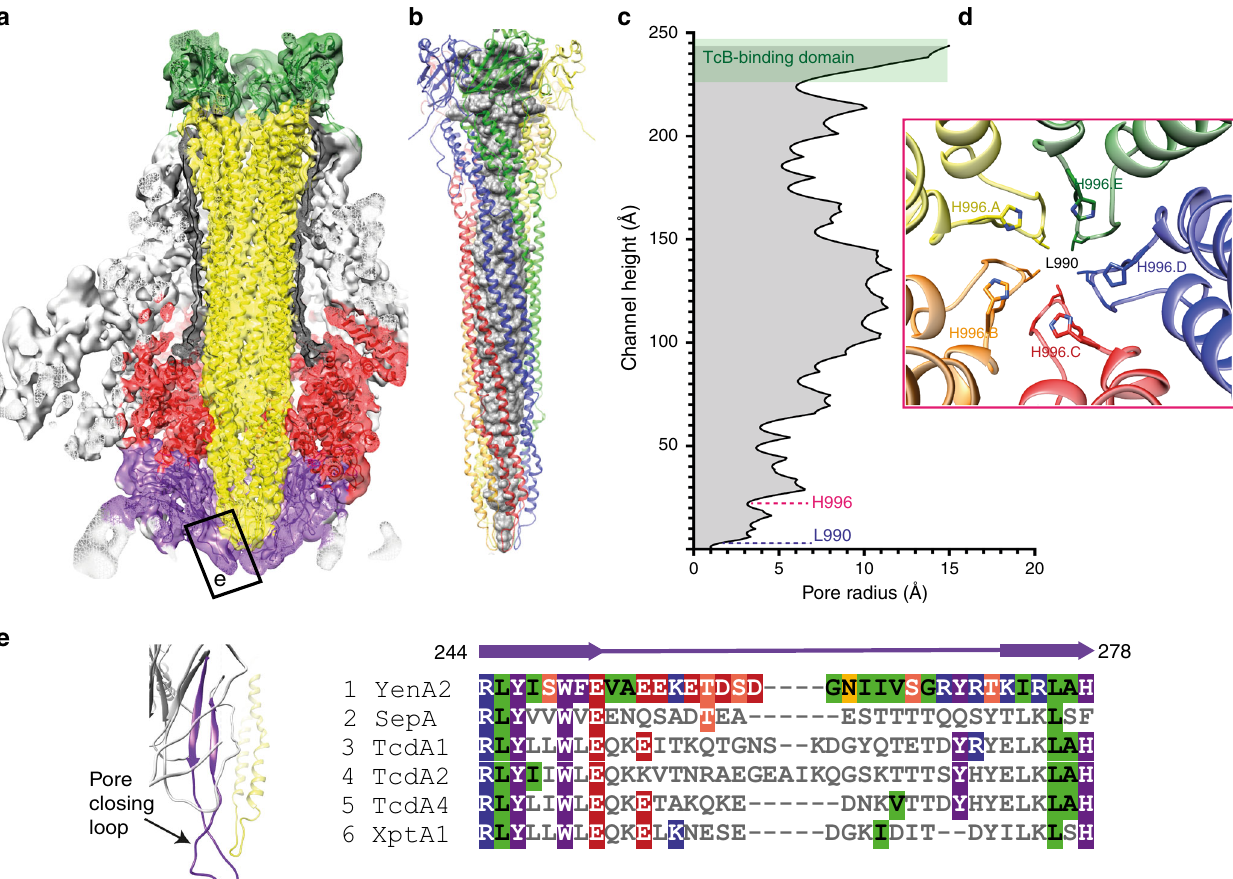
Fig. 3 Properties of the encapsulated YenTcA translocation pore. a A central section of the YenTcA pre-pore structure highlighting the pentameric translocation pore (yellow) as well as the neuraminidase-like domains that close the bottom of the complex (purple). b , c The translocation pore has a maximum radius of 15 Å and narrows towards the bottom, constricted by H996 (also shown as viewed from above in d ) and L990. In b , d , the helices are coloured by protomer. e The extended hairpin loop structure of the neuraminidase-like domain that seals the pore (highlighted in purple). The loop sequence in particular is not well conserved with the equivalent sequences of TcA proteins from other ABC